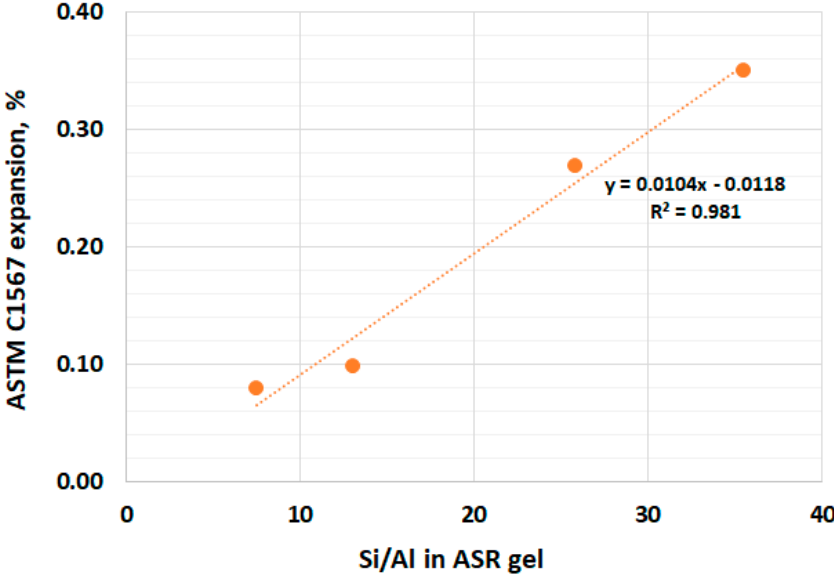
Figure 6. The relationship between the ASTM C1567 expansion and the Si/Al ratio in the ASR gel.